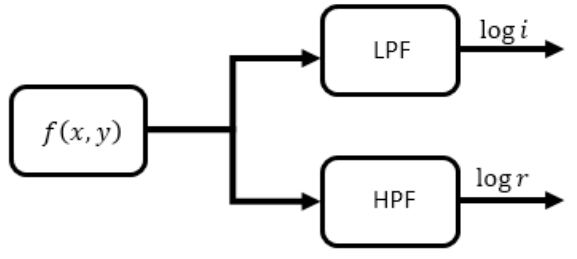
Figure 2. Homomorphic decomposition of an image.